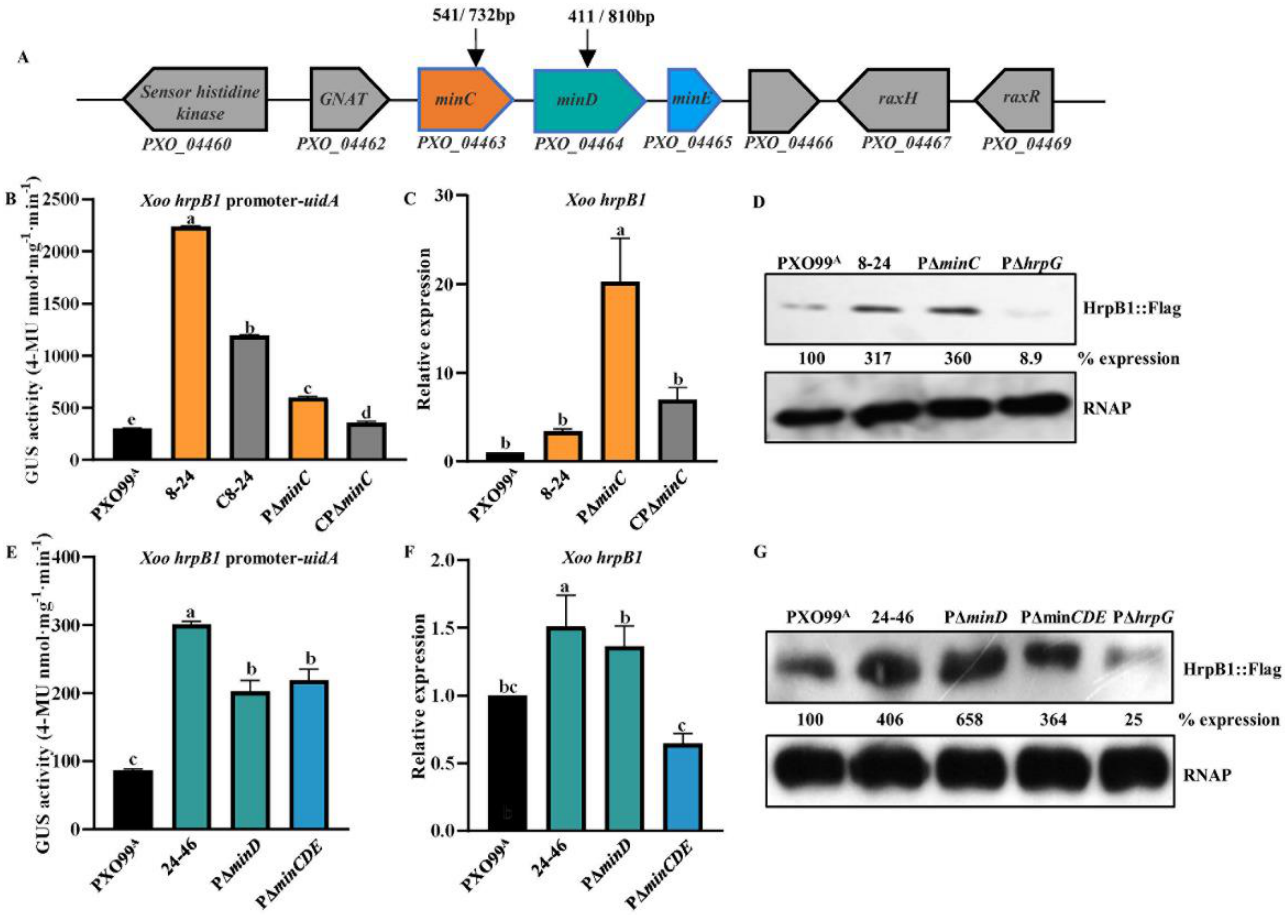
Figure 1. The Xoo Min system negatively regulates hrpB1 expression. ( A ) Genomic location of Min system on the Xoo PXO99 A chromosome. Arrows indicate the Tn5 transposon insertion sites in the nucleotides 541 of minC and the nucleotides 411 of minD , respectively. ( B ) The hrpB1 promoter- driven GUS activity of Xoo wild-type PXO99 A , 8–24, C8–24, P ∆ minC , and CP ∆ minC in XOM3 at 3 hr post-induction. ( C ) Expression ratios of hrpB1 in 8–24, P ∆ minC , and CP ∆ minC compared to that in Xoo wild-type PXO99 A by qRT-PCR. ( D ) The abundance of HrpB1 proteins in PXO99 A , 8–24, and P ∆ minC by Western blotting. P ∆ hrpG as a negative control of HrpB1 protein expression. ( E ) The hrpB1 promoter-driven GUS activity of PXO99 A , 24 –46, P∆ minD , and P∆ minCDE in XOM3 at 3 hr post-induction. ( F ) Expression ratios of hrpB1 in 24 –46, P∆ minD , and P∆ minCDE compared to that in Xoo wild-type PXO99 A by qRT-PCR. ( G ) The abundance of HrpB1 proteins in PXO99 A , 24 – 46, P∆ minD , and P ∆ minCDE by Western blotting. P ∆ hrpG as a negative control of HrpB1 protein expression. The total protein extracts were analyzed by Western blotting using anti-FLAG antibodies. RNAP, RNA polymerase subunit alpha from E . coli was used as a loading control. Relative protein abundance was calculated by ImageJ software. Similar results were observed in two independent experiments. As assessed by Duncan’s test, different letters indicate statistically significant differences, and the same letter displays no significant differences ( p < 0.05) between Xoo